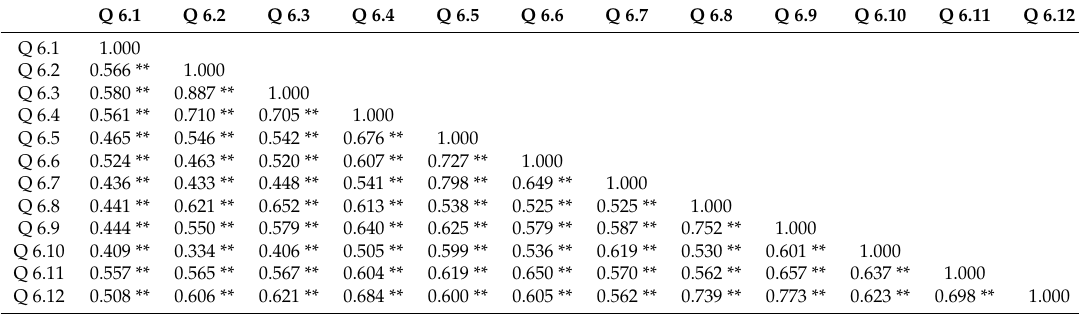
Table 2. Correlation coefficients between questions referring to attitudes toward inclusion.